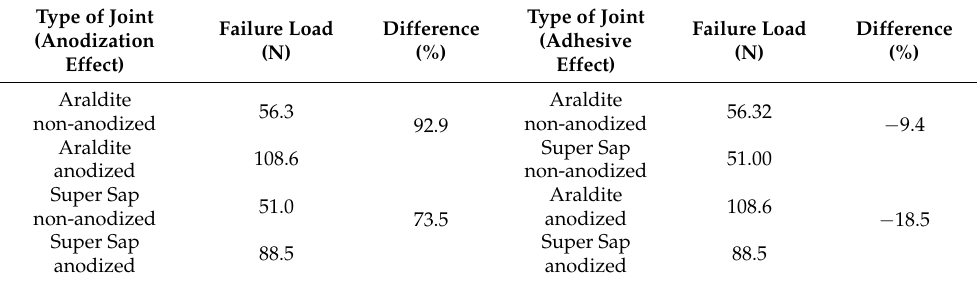
Table 4. Comparison of average failure load values for the different types of Aluminum single-lap joints.